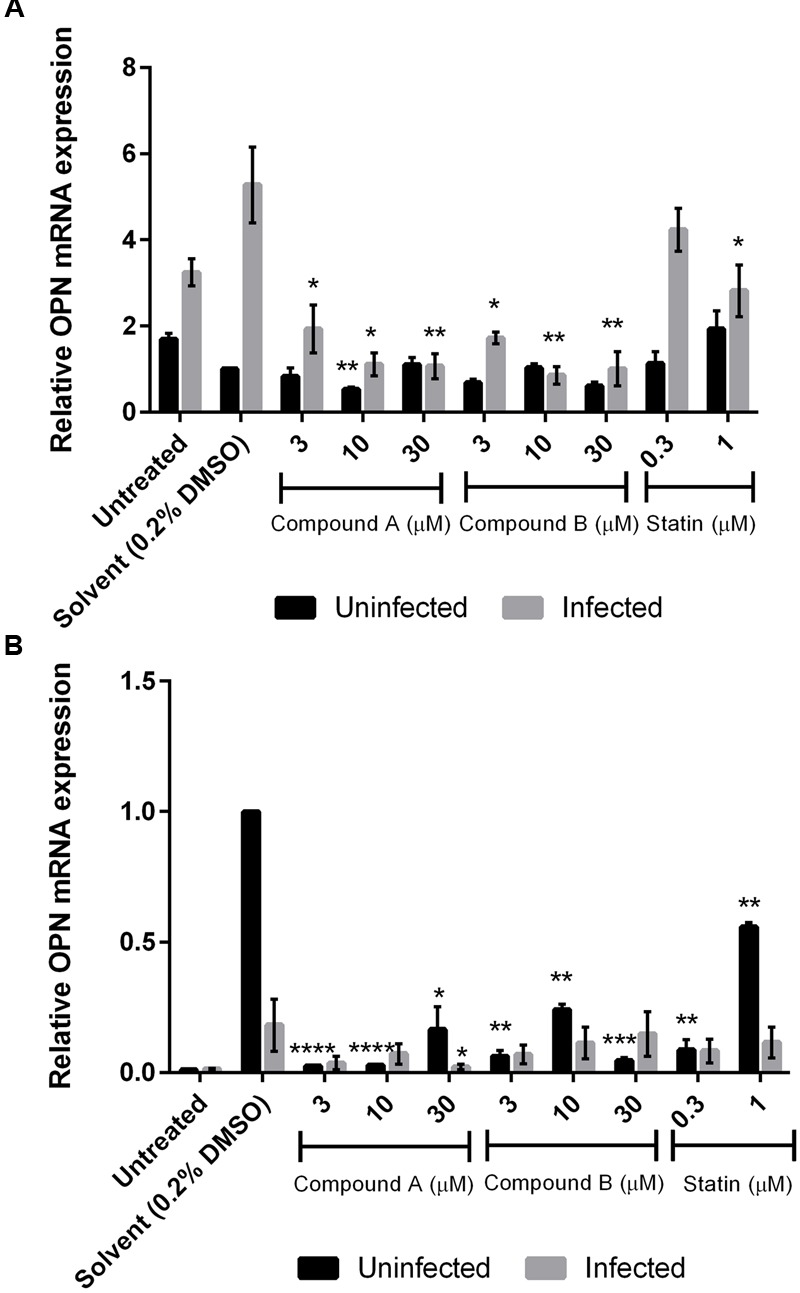
Changes in OPN mRNA expression by treatment with compounds A and B in DENV-infected cells. Uninfected and DENV-infected THP-1 (A) or 293T (B) cells were left untreated or treated with compound A or compound B (range: 3–30 μM), or statin (range: 0.3–1 μM) for 72 h. Total RNA was extracted from cell lysates and analyzed by RT-qPCR. GAPDH was used as reference gene to normalize expression levels. Results show the mean of two independent experiments. ∗P < 0.05, ∗∗P < 0.01, ∗∗∗P < 0.001, ∗∗∗∗P < 0.0001 vs. control (0.2% DMSO; unpaired two-tailed t-test). Data represent mean ± SEM.